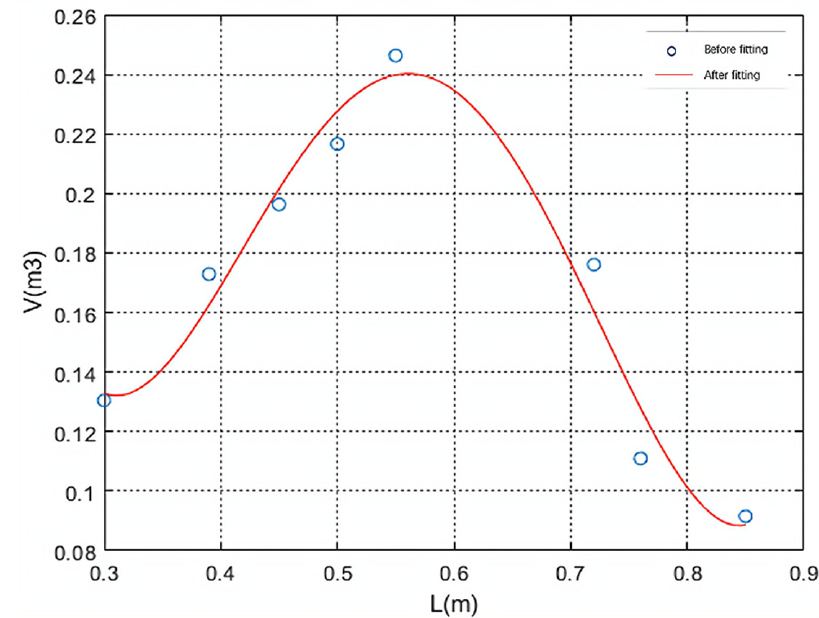
Figure 6. V-L blast funnel characteristic curve.